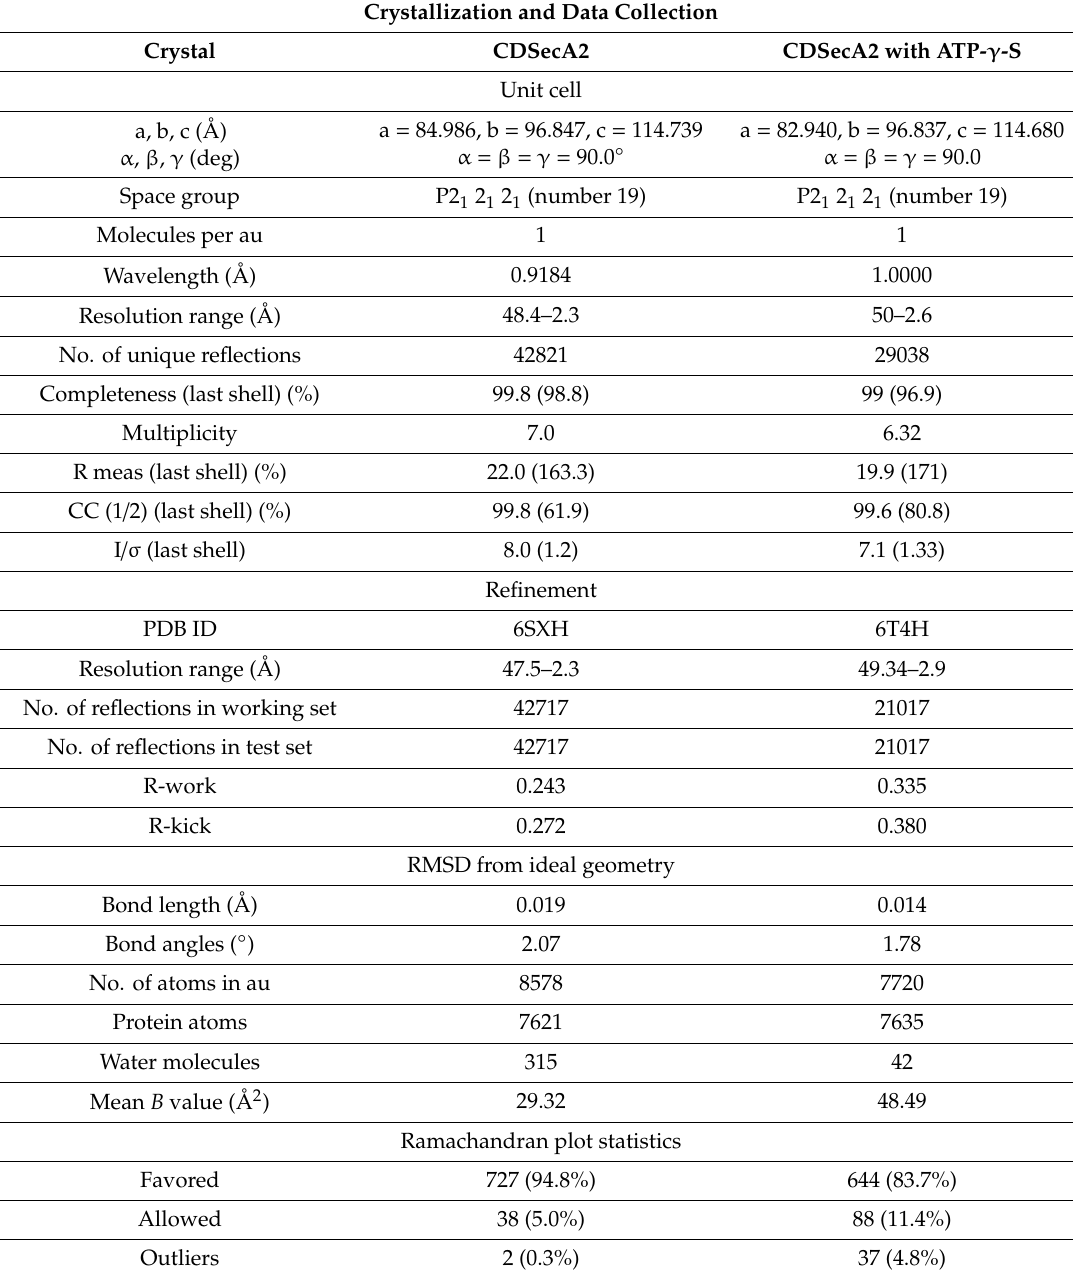
Table 1. Crystallographic